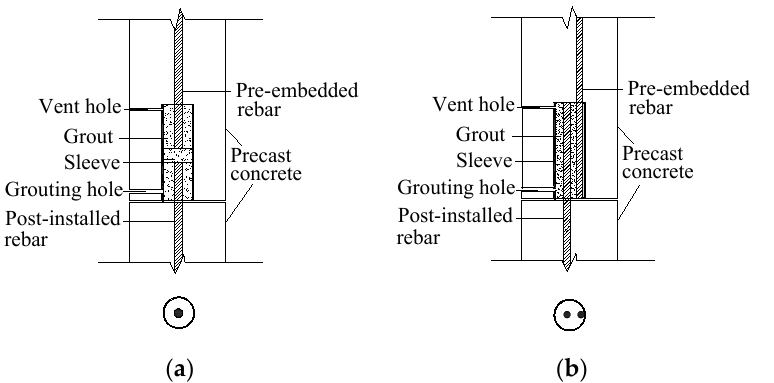
Figure 1. Schematic diagrams of grouted splice connector and grouted sleeve lapping connector. ( a ) Grouted sleeve splice connector, ( b ) Grouted sleeve lapping connector.